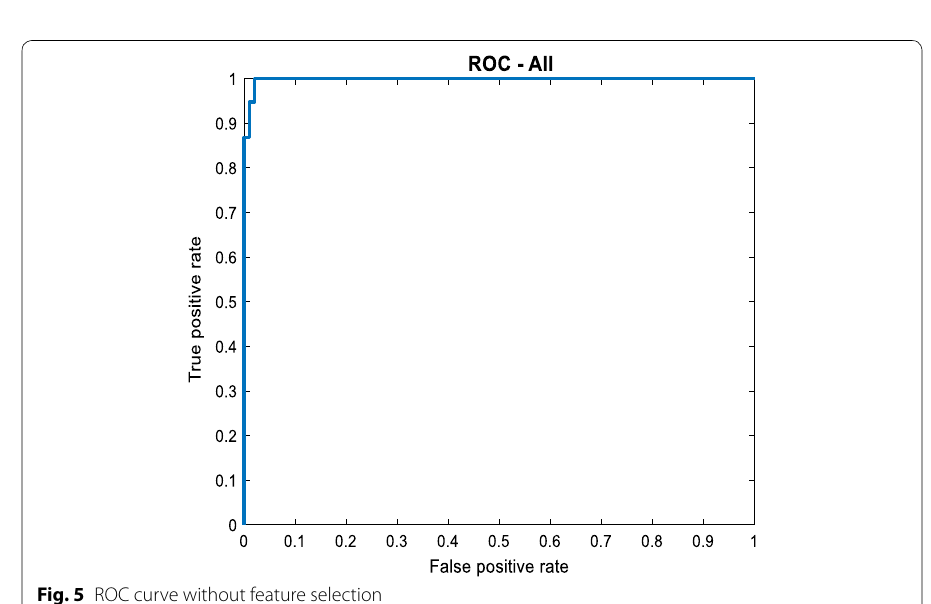
Fig. 5 ROC curve without feature selection